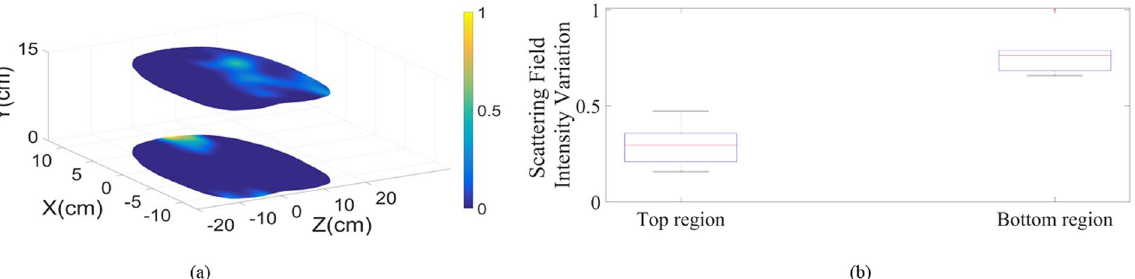
Figure 7. ( a ) Reconstructed images for top and bottom regions of the torso of one of the tested healthy subjects. ( b ) Scattering field intensity variation range for top and bottom regions for all of the six